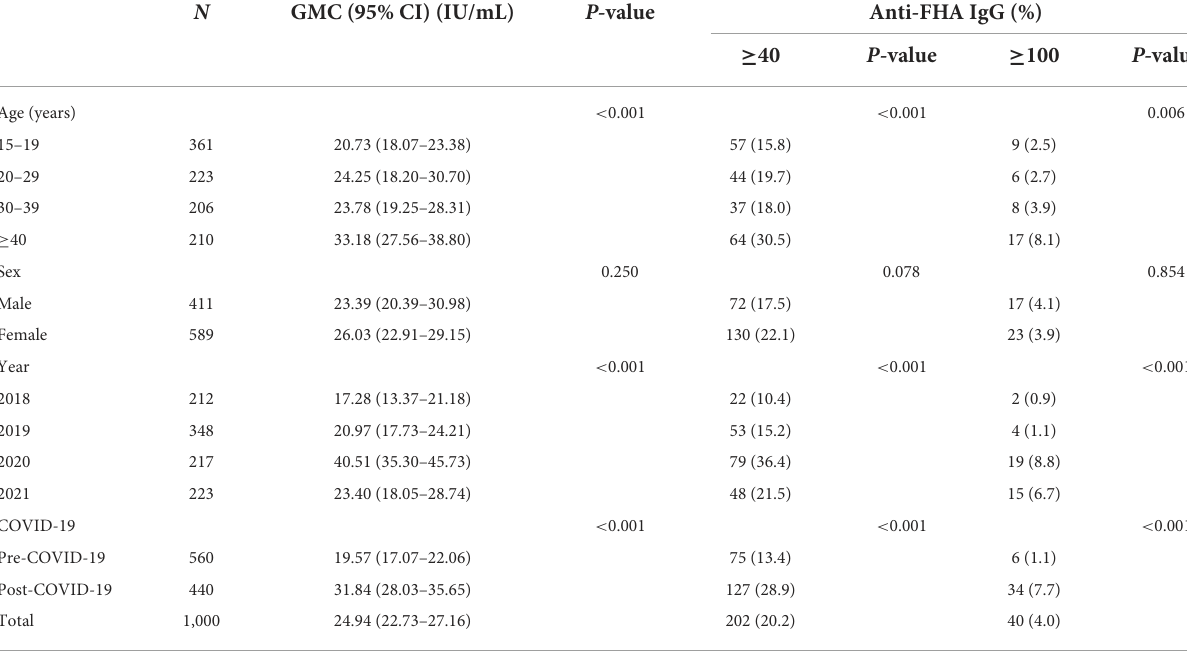
TABLE 2 The GMC and positivity rate of anti-FHA IgG antibodies in subjects aged ≥ 15 years.